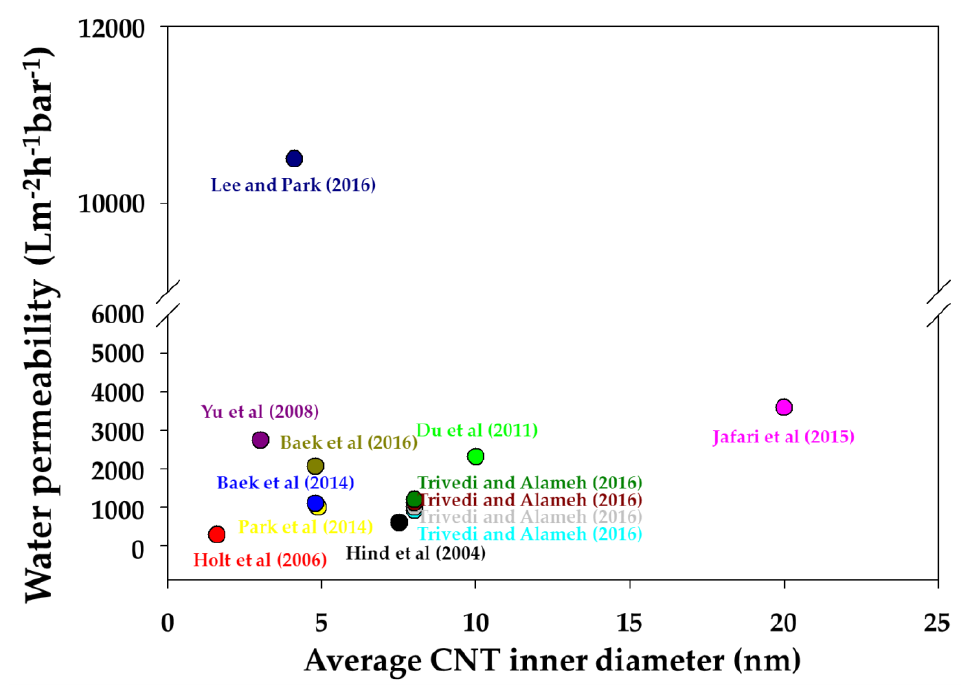
Figure 6. Analysis of water permeability according to the average carbon nanotube (CNT) inner diameter of vertically aligned CNT (VACNT) membranes [17,18,70,73,75,86,95–98] .